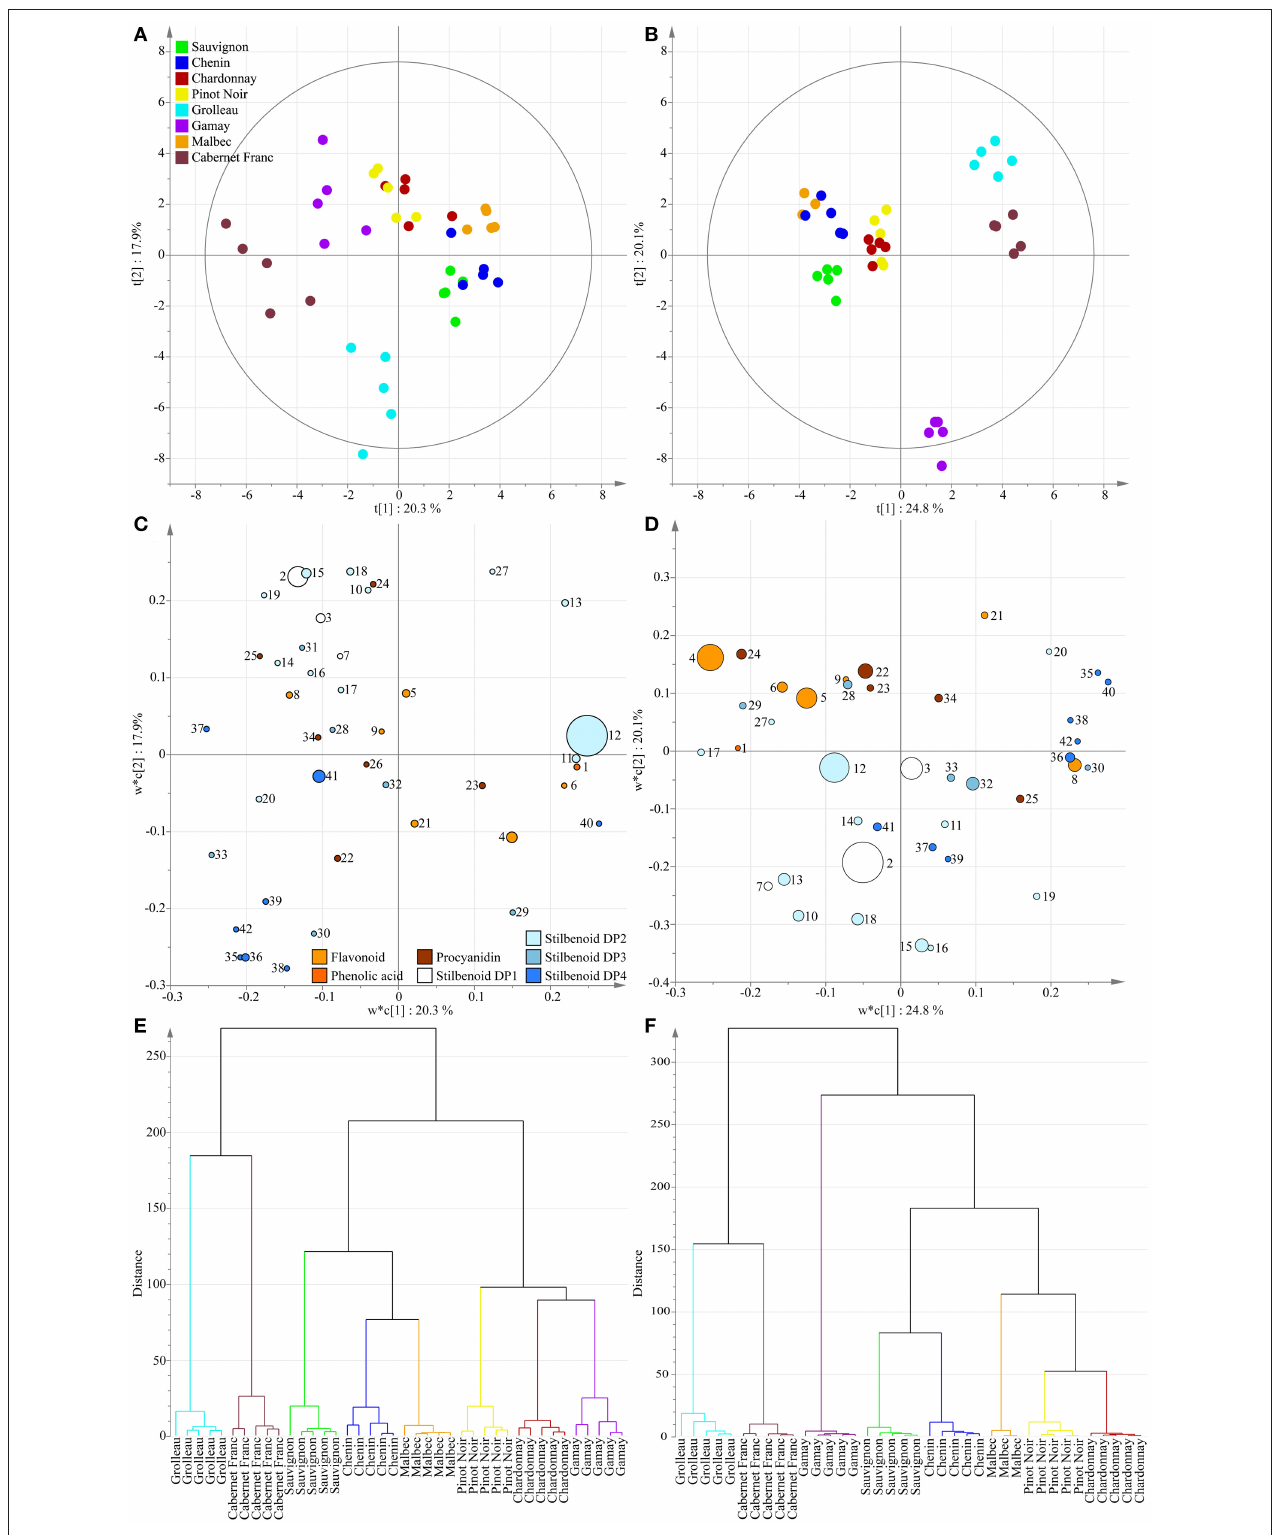
FIGURE 5 | Supervised classification using PLS-DA with “genotype” as dependent variable on polyphenol data from grape stems of eight genotypes in 2013 (A,C,E) and 2017 (B,D,F) . Score plots (A,B) , PLS-DA loading plots (C,D) , and dendrograms of HCA (E,F) using Ward’s minimum variance method for the loading matrix. Variables in score plot were colored according to genotype. Variables in the loading plot were colored according to polyphenol class with round size relative to the abundance of the selected ion. Numbers indicate the ID of the compounds as given in Table 2 .